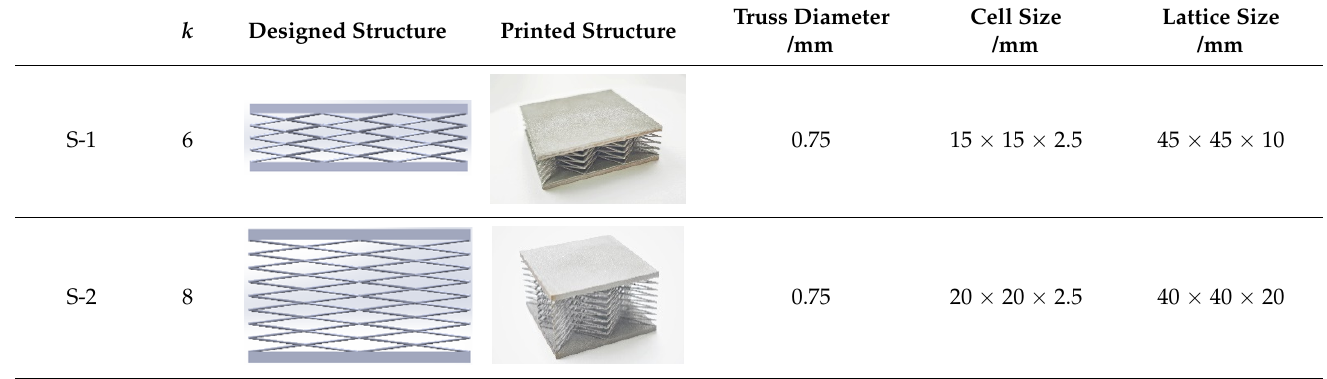
Table 2. Components of TC4 powders.